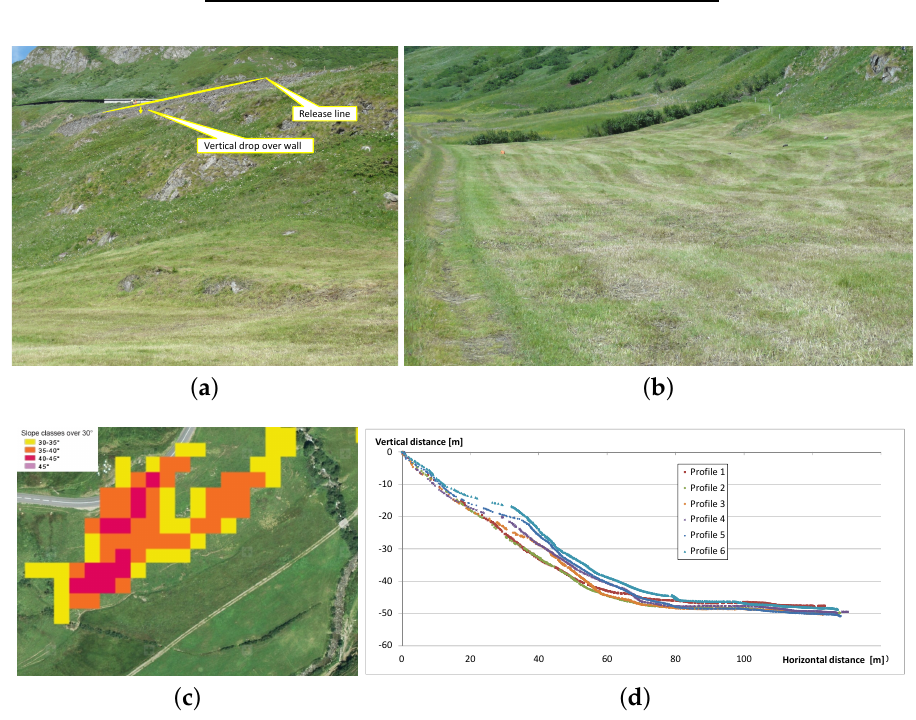
Figure 2. ( a ) Release, transit and ( b ) runout zones. ( c ) Terrain inclination (slope classes) over 30 ◦ (source: maps.admin.ch) and ( d ) six slope profiles on the test site as marked in Figure